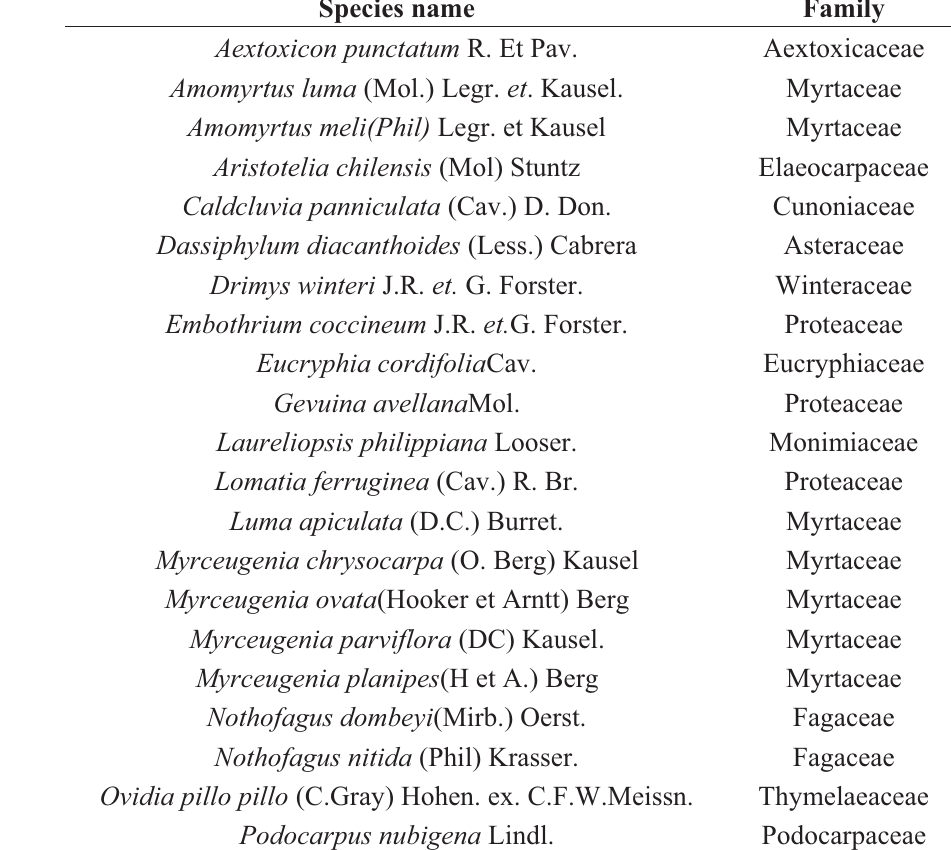
Table S1. Tree species included in the cluster